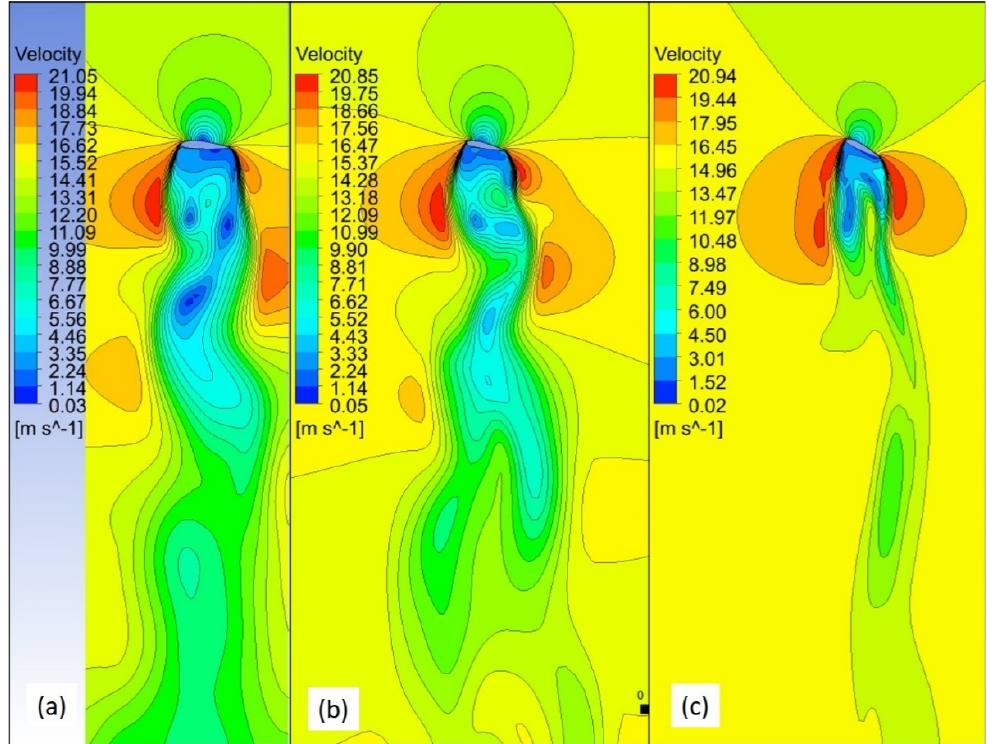
Figure 8. Velocity profile and wake formation at three locations of the span, ( a ) 20% chord from root, ( b ) 50% chord length from rot, ( c ) 90% chord length at 15 m/s (4° angle).